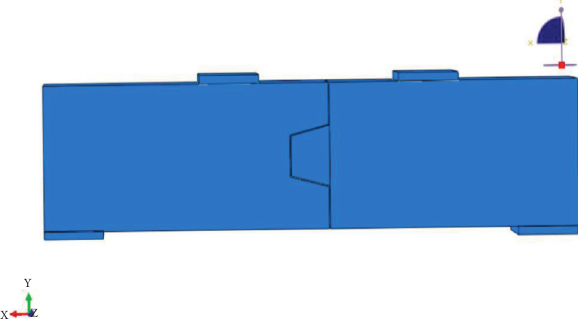
Figure 18: Calculated model of long grouted single mortise-tenon